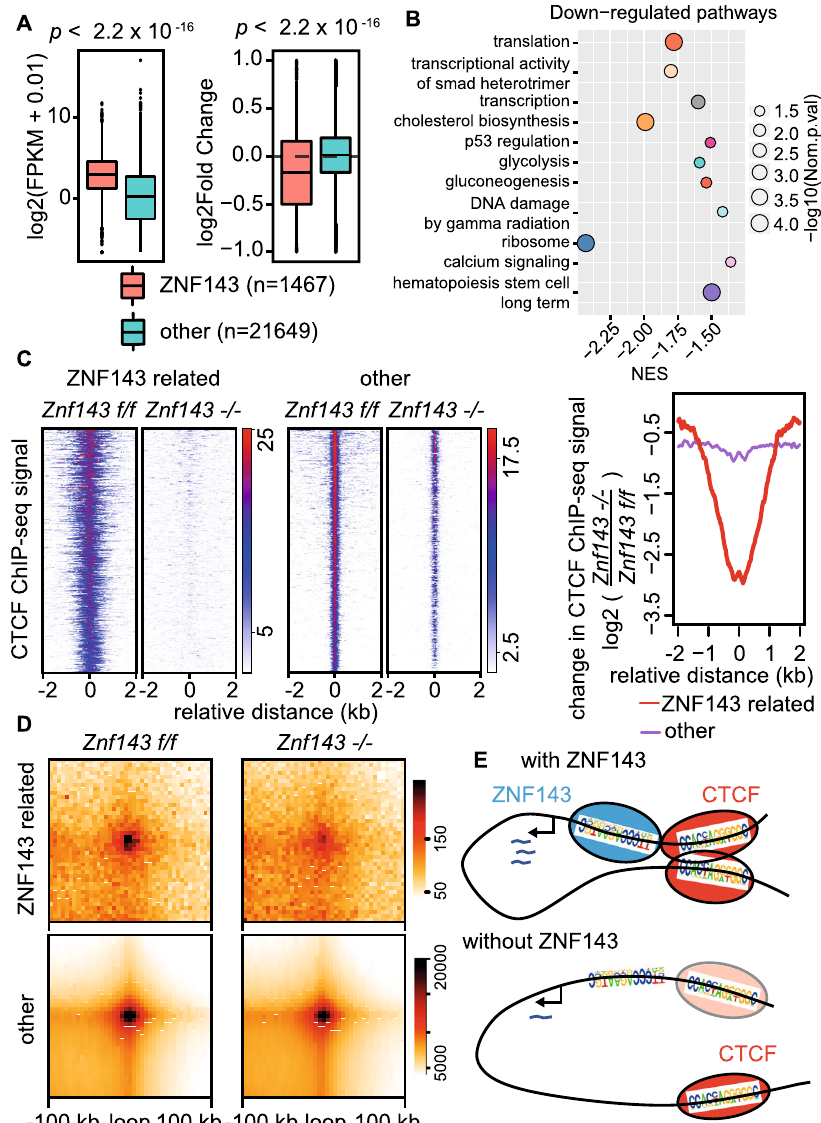
Fig. 5 ZNF143-CTCF-bound loops regulate key genes and pathways contributing to the stem cell phenotype. a Left panel, box plot describes log2 fragment per kb per million (FPKM) of genes in Znf143 f/f HSCs that are 1) highly enriched of ZNF143 on their promoters (ZNF143, 1467 genes) or 2) not associated with high ZNF143 enrichment (other, 21,649 genes). Right panel, log2 fold change in expression of genes grouped as in left panel. P values determined by the two-sided Mann Whitney Wilcoxon Test. n = three biological replicates. Boxplot represents median and the 25 th and 75 th percentiles of the distribution. The upper and lower whisker represents data no further than 1.5 times the IQR from 25th or 75th percentiles. b Bubble plot describes downregulated pathways after Znf143 excision discovered by Gene Set Enrichment Analysis (GSEA). The X -axis represents normalized enrichment score (NES), while bubble size represents normalized p -value (transformed into -log10 format). P -value is determined as described previously 52 . c Left panel, heatmap of the CTCF ChIP-seq signal within ±2 kb from CTCF motifs on loop anchors. Each column represents the relative distance to the CTCF motif, while each row represents normalized read counts of CTCF on the loop anchor region. Loops are divided into two groups according to ZNF143 binding on their anchors. The right panel demonstrates the mean plot of the average changes of the CTCF ChIP-seq signal within ±2 kb from CTCF motifs on loop anchors. n = two biological replicates. d Aggregate peak analysis demonstrates the intensity change of loops grouped as described in ( c ). Loop intensities are aggregated at the center of a 100 kb window in 5 kb resolution. e Proposed model depicting regulation of CTCF-bound loops by